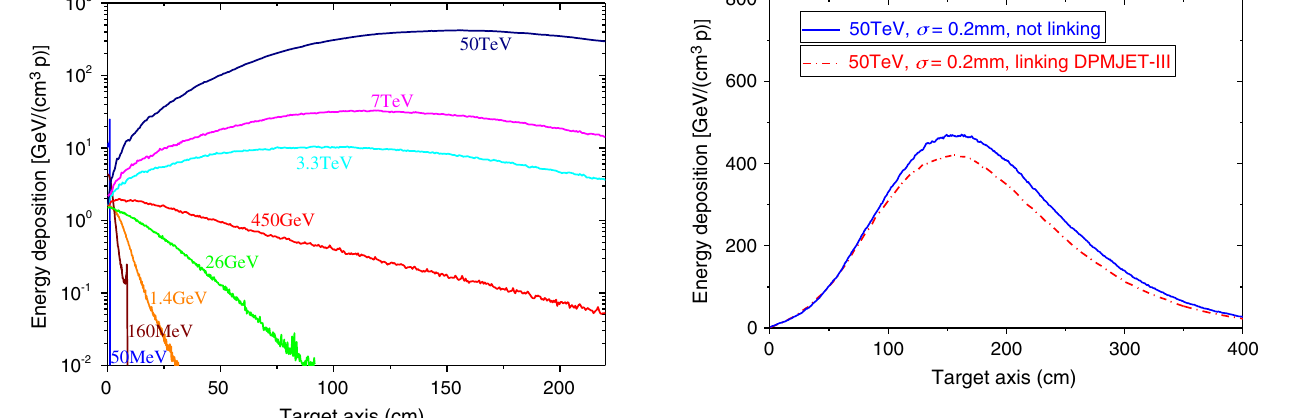
FIG. 16. Energy deposition of 50 TeV proton in graphite along the target axis with and without linking FLUKA and DPMJET-III. Without linking, the maximum energy deposition is 11% higher than that for the case of